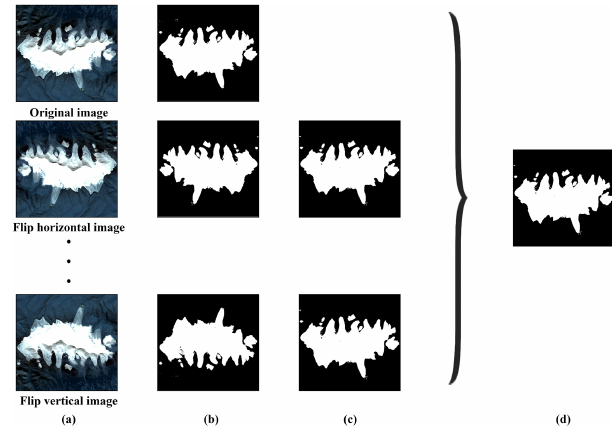
Figure 8. Test-time augmentation result. (a–d) RGB image ob- tained on 29 September 2020, its copies, prediction results, reduc- tive copy results and the result of the vote,